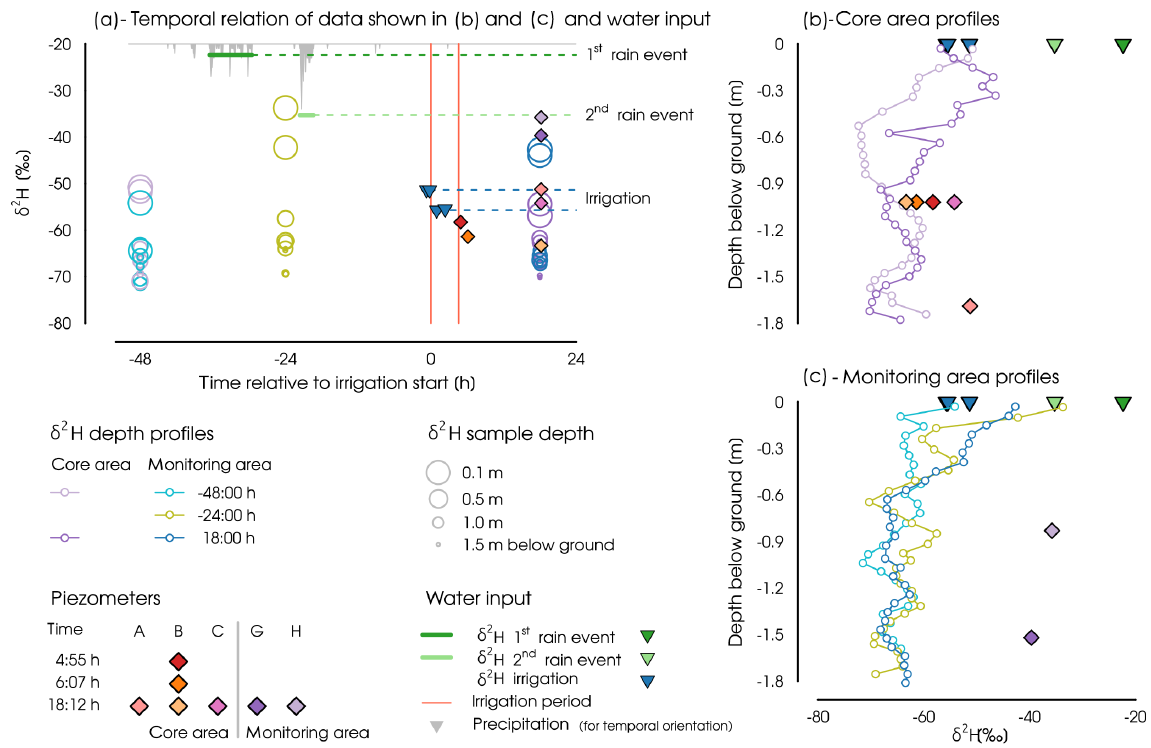
Figure 10. Stable isotope data from precipitation, irrigation, piezometers, and pore water samples. (a) Temporal dynamics of pore water and piezometer δ 2 H in relation to water input by precipitation (bulk samples) and irrigation. Pore water data are shown only for the depths of piezometer filters (compare with panels (b) and (c) for depths) and the top soil (0.1m below ground). The graph shows the direct impact of the water input (dashed lines) on the pore water isotope composition of the top soil. (b, c) Pore water and piezometer data over depths, separated by core area and monitoring area. Water input stable isotope data are indicated at the soil